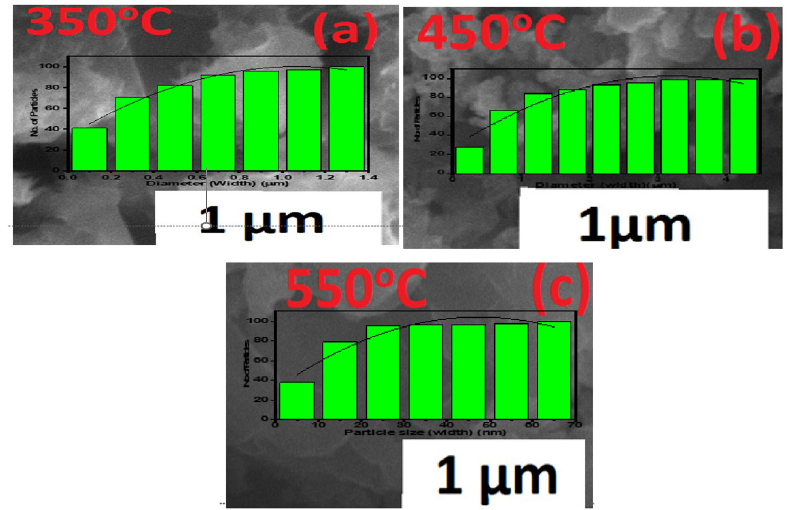
Figure 3: SEM pictures of CuO samples calcinated at ( a ) 350, ( b ) 450, and ( c )